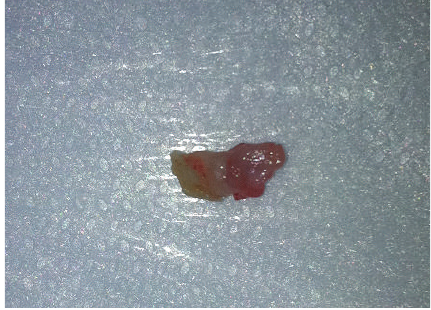
Figure 1: One-month-old infant showing the presence of two natal teeth in the lower arch and ulcerated lesion in the ventral surface of the tongue.